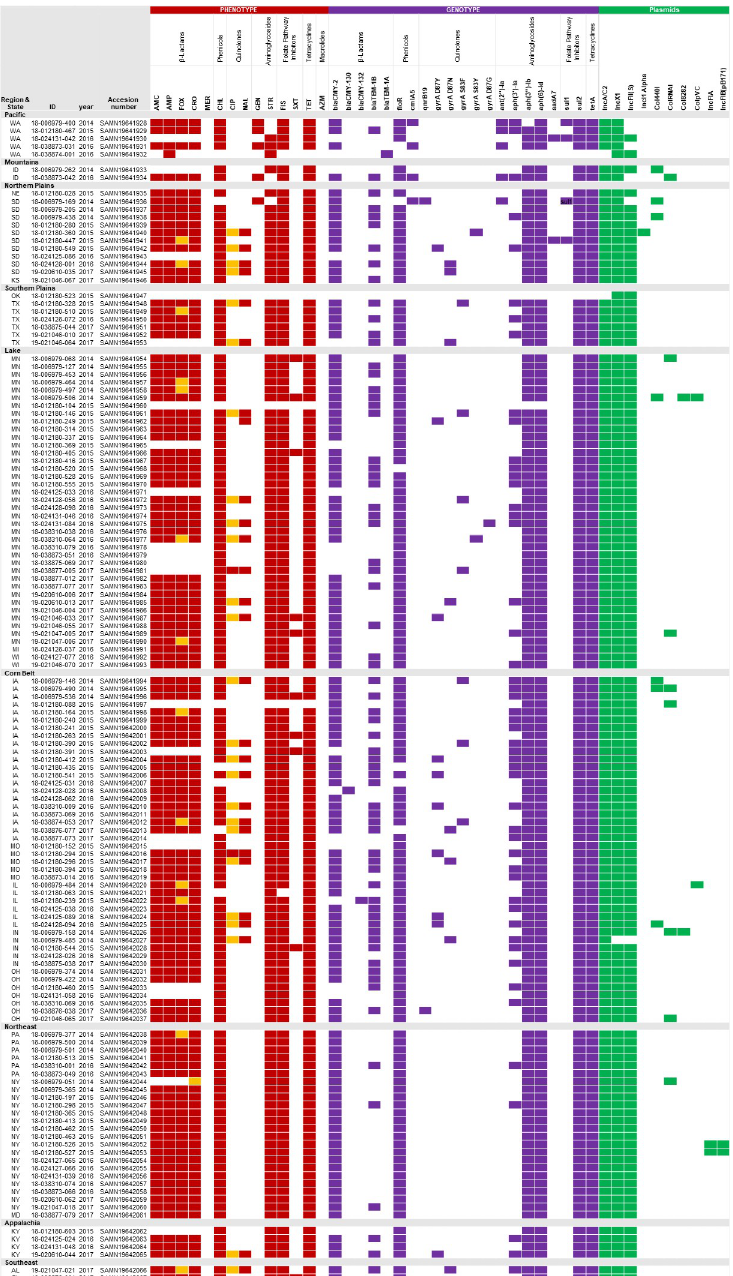
Fig 1. Antimicrobial susceptibility, distribution of ARGs, mutations, and presence of plasmids from the S . Dublin isolates in this study by state and region. Red: resistant, Orange: Intermediate, Violet: presence of gene or mutation, Green: presence of